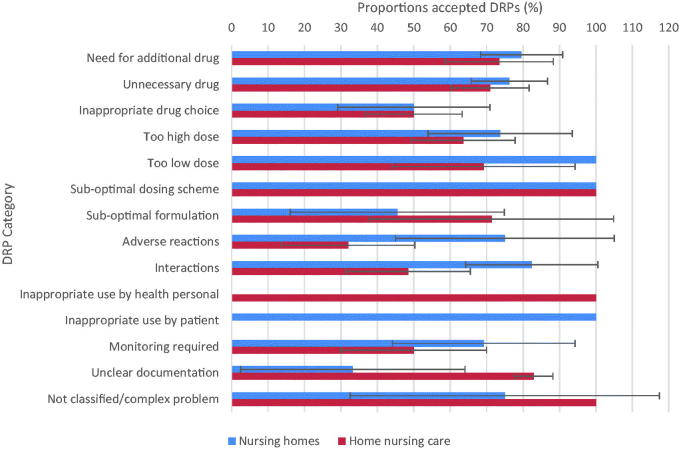
Proportions of accepted DRPs (%). Error bars represent 95% confidence intervals.